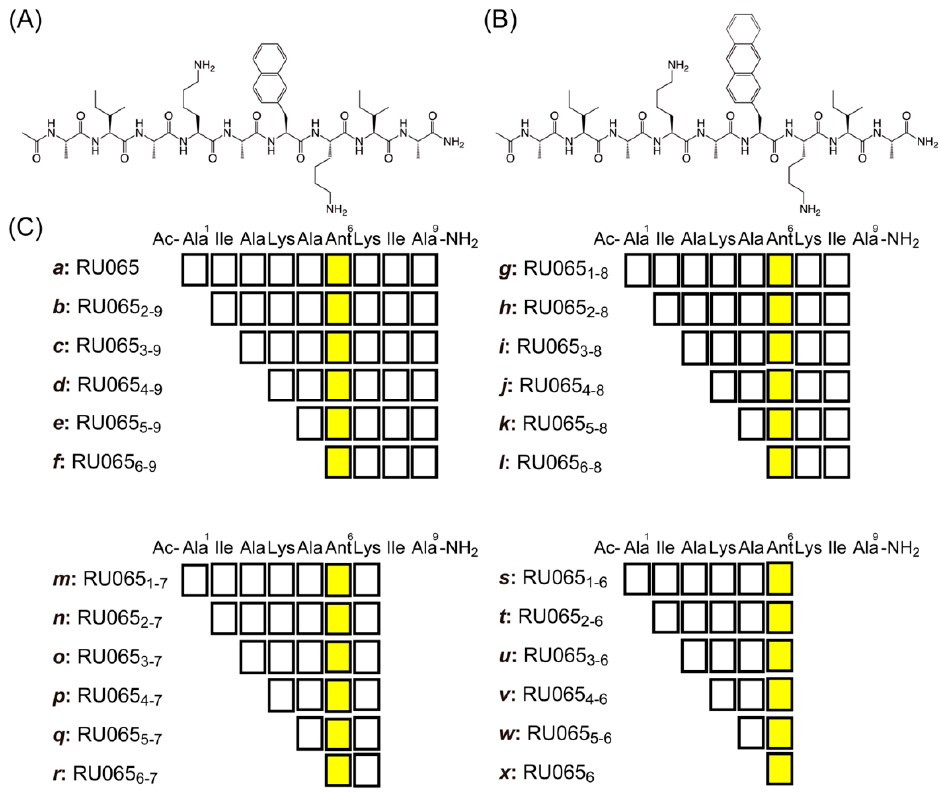
Figure 1. Molecular structures of ( A ) RU006 and ( B ) RU065 ( a ), ( C ) amino acid sequences of RU065 ( a ) and its fragment peptides ( b – x ). Yellow squares show the Ant residues at the sixth position of the original RU065 ( a ) while white squares show amino acid residues other than Ant comprising RU065 ( a ). Ant = L-2-anthrylalanine. Molecular structures of the fragment peptides used in this study are shown in Figure S1.